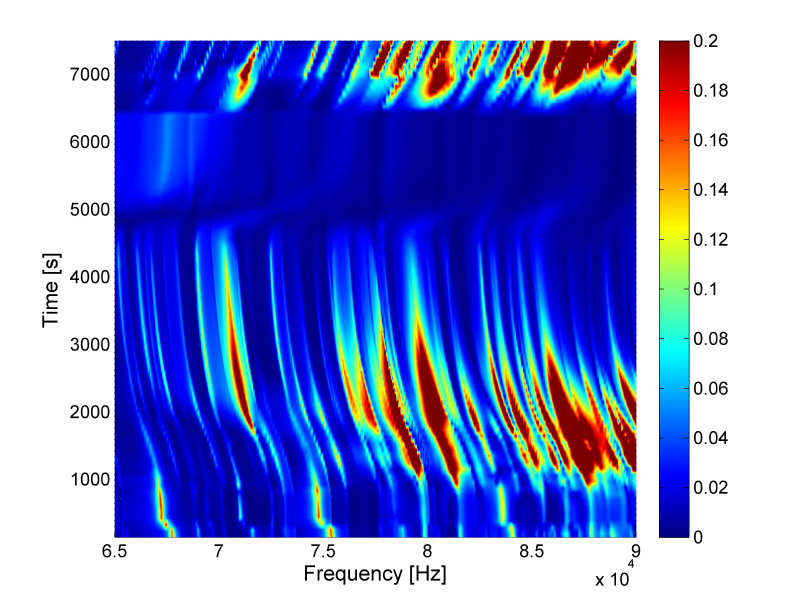
Figure 3. Change in the response spectrum during curing over